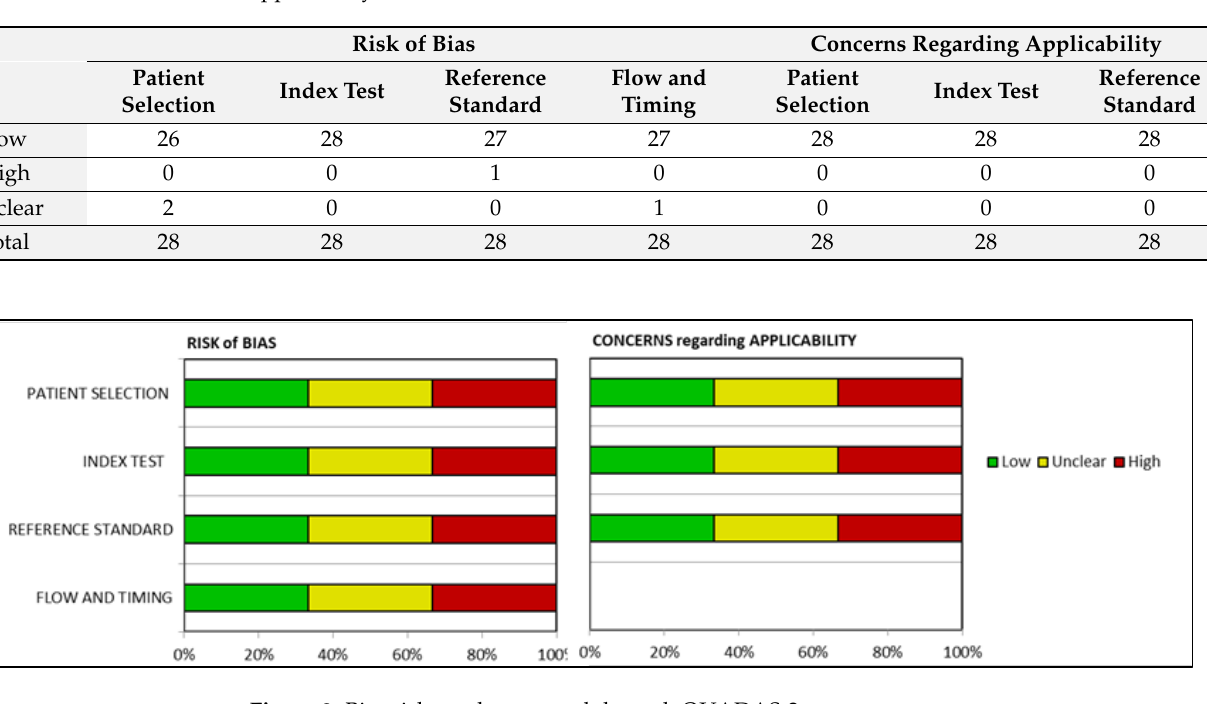
P = patient selection; I = index test; R = reference standard; FT = fl ow and timing. ✓ indicates low risk; ✗ indicates high risk; ? indicates unclear risk. indicates